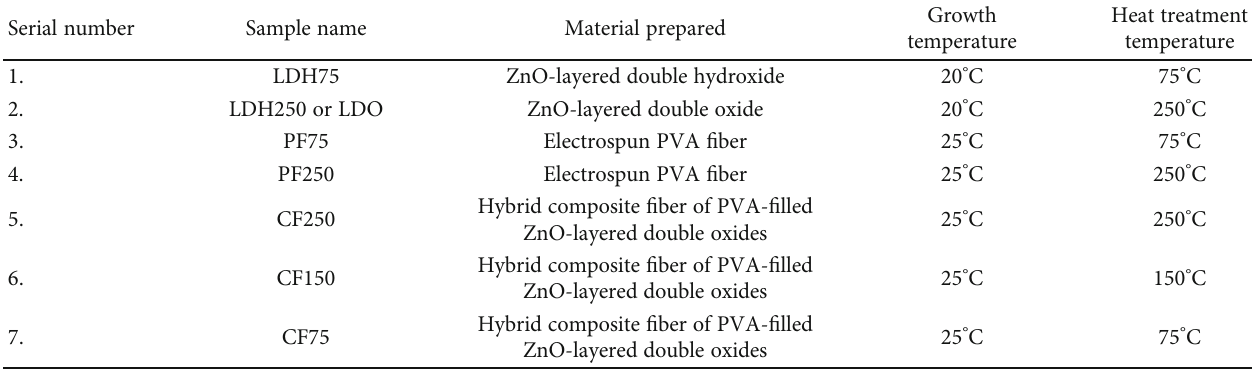
Table 1: Details of the materials used in PVA/LDH hybrid nanocomposite fi bers, with heat treatment